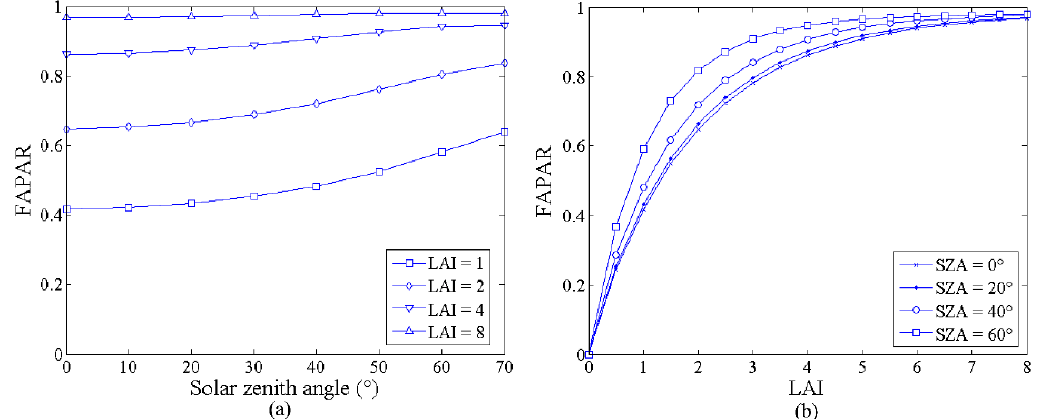
Figure 4. Effects of SZA and leaf area index (LAI) on FAPAR simulated from FAPAR-P model under VIS = 30 km: ( a ) effects of SZA on FAPAR with LAI = 1, 2, 4 and 8; and ( b ) effects of LAI on FAPAR with given SZA.